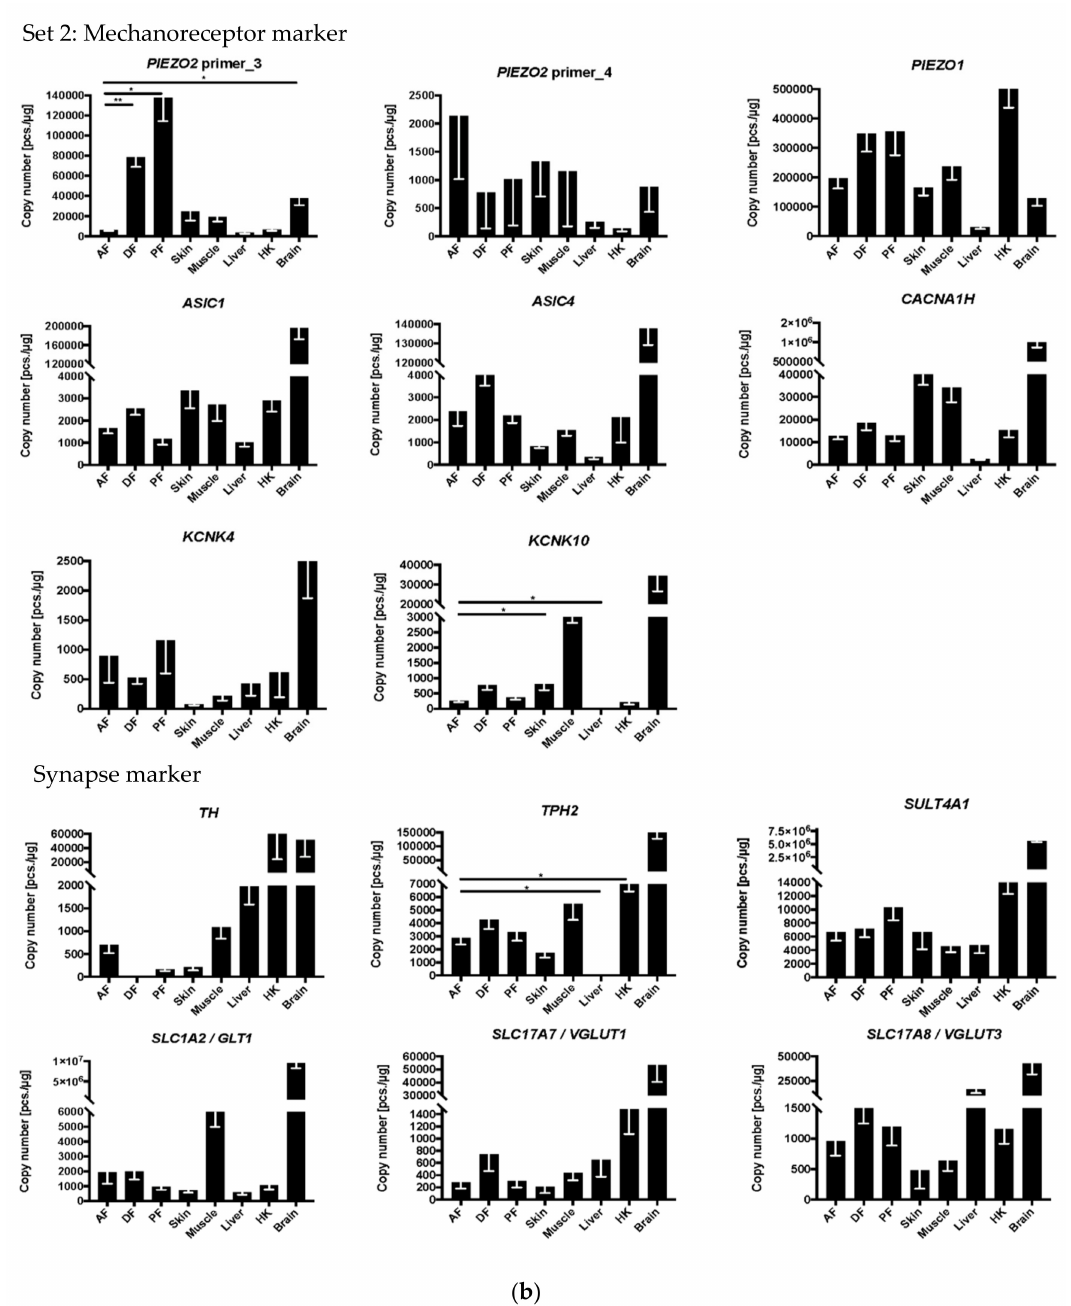
Figure A1. ( a ). Expression levels of the remaining neuron and glial cell marker genes from Set 1 across tissues in O. mykiss . The expression levels are given as absolute copy numbers (per 1 µ g RNA) normalized against three reference genes. Statistically significant deviations are indicated only between AF and the other tissues. Expression values determined in the brain were excluded from the statistical evaluation. Significance levels are indicated by * p ≤ 0.05, ** p ≤ 0.01, *** p ≤ 0.001. Error bars indicate the SEM. ( b ). Expression levels of mechanoreceptor-encoding and synapse marker genes from Set 2 across tissues in O. mykiss . The expression levels are given as absolute copy numbers (per 1 µ g RNA) normalized against three reference genes. Statistically significant deviations are indicated only between AF and the other tissues. Expression values determined in brain were excluded from the statistical evaluation. Significance levels are indicated by * p ≤ 0.05, ** p ≤ 0.01, *** p ≤ 0.001. Error bars indicate the